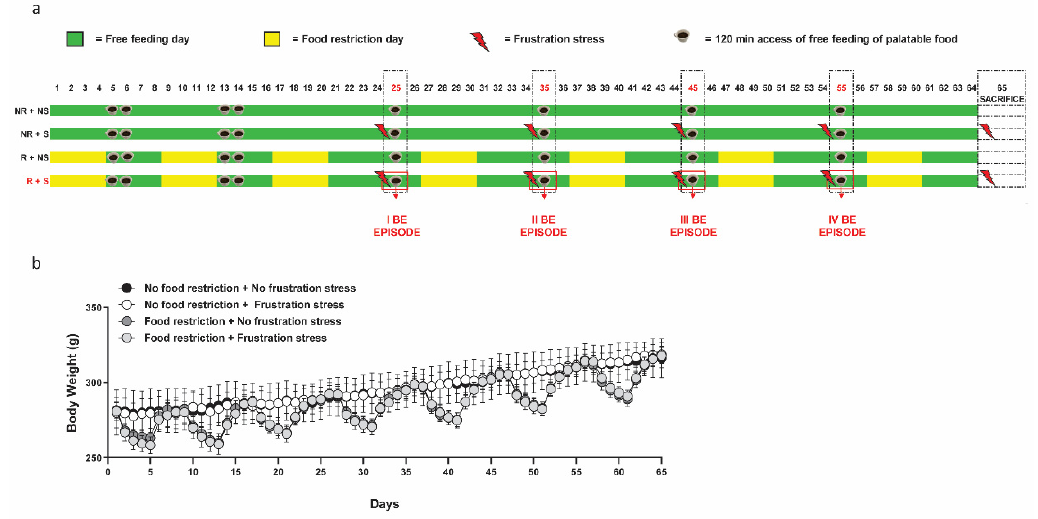
Figure 1. Schematic representation of BE model ( a ). Mean ± SEM ( b ) of body weight (grams) for the entire duration of the study; n = 6 per group. NR + NS: Non-restricted and Non-stressed rats; NR + S: Non-restricted and Stressed rats; R + NS: Restricted and Non-stressed rats; R + S: Restricted and Stressed rats.